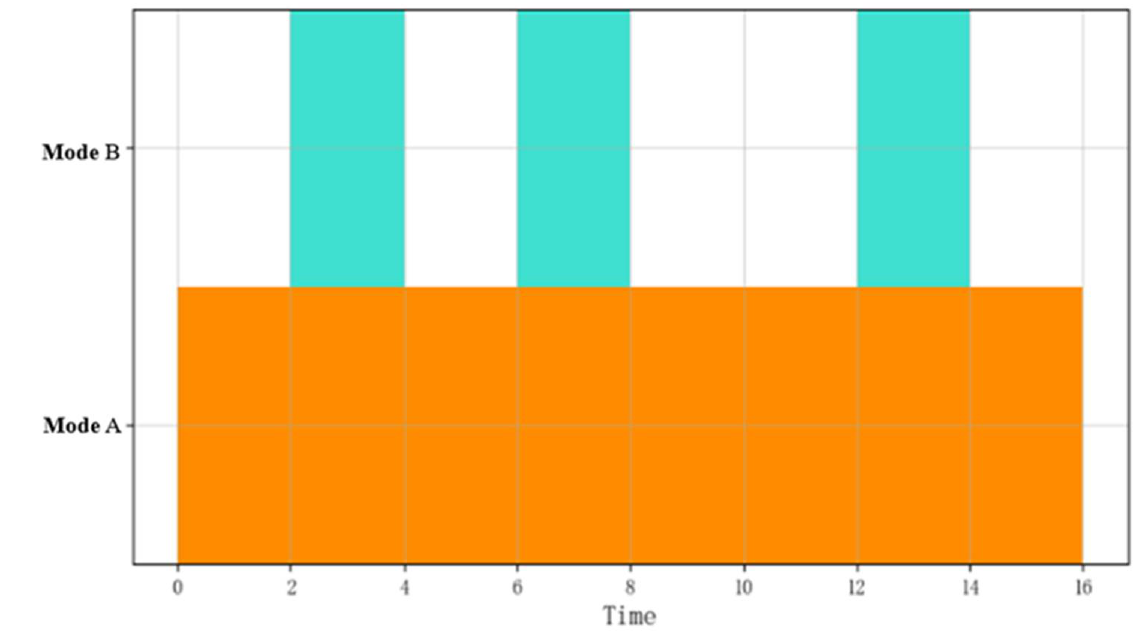
Figure 6. Visualization of the event flow embedded composition.